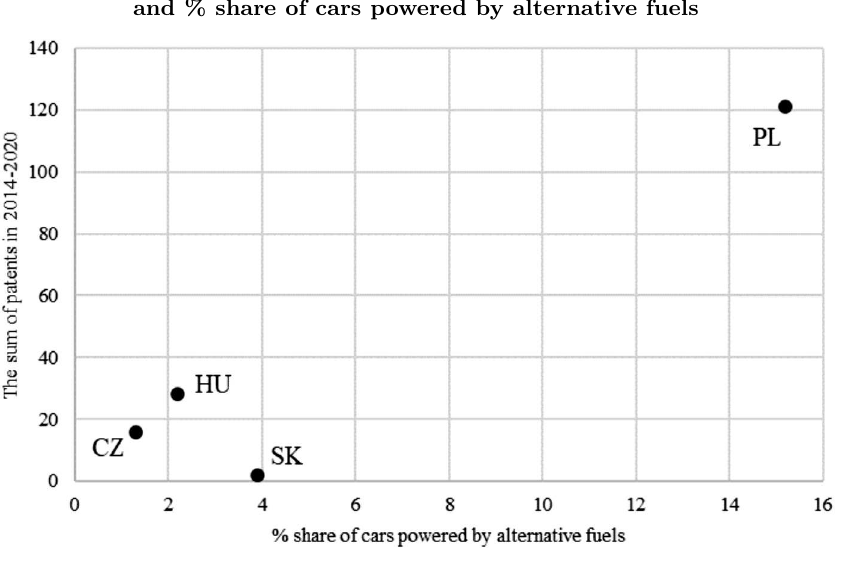
Source: own elaboration based on figure 4 and tables